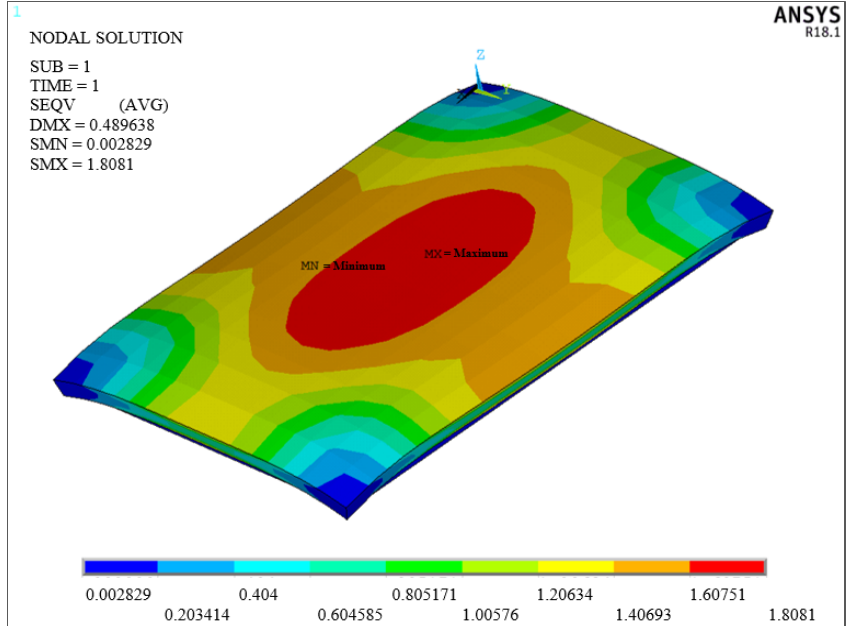
Figure 2. Maximum stresses induced by a positive gradient (ANSYS R18.1).